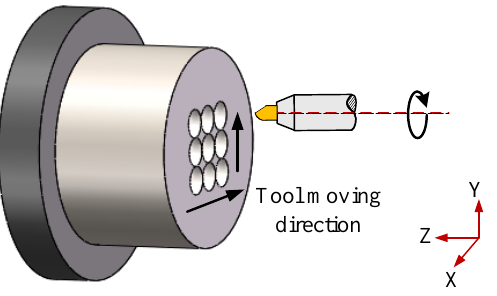
Figure 23. Single point diamond cutting process of ChG microlens arrays.